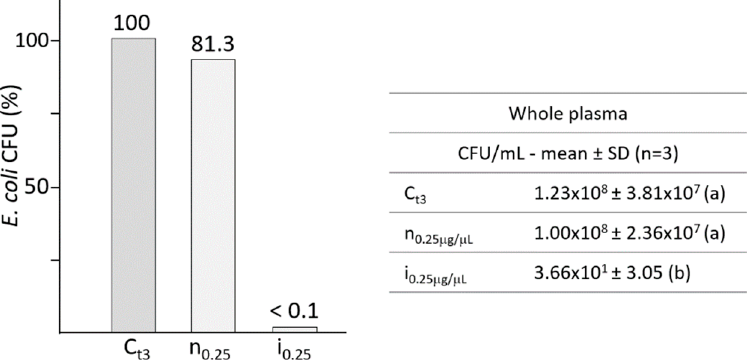
Figure 1. Bacterial growth of E. coli in the presence of the humoral fraction of whole hemolymph (0.25 μ g/ μ L), from not infected (n) and infected (i) B. mori larvae. The bacterial growth after 3 h of incubation in culture broth was considered as the control (C t3 ), assuming it as 100% of survival. The table resumes the growth of E. coli expressed as CFU/mL. Different letters within brackets (a,b) indicate significant differences ( p < 0.05 Tukey test). C: control; n: plasma from not infected larvae; i: plasma from infected larvae.